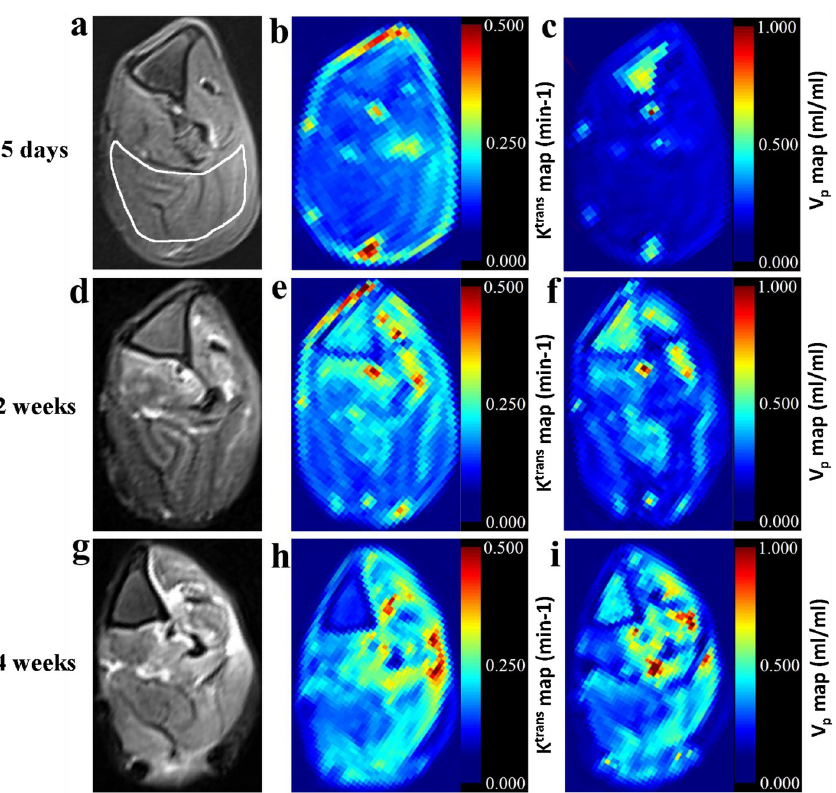
Fig 3. Axial fat-suppressed T2-weighted MR images of the left gastrocnemius muscle (outlined muscle in image) obtained with rabbits in the prone position. (a): At 5 days after surgery, image shows grade 1 signal intensity (ie, signal intensity was isointense or slightly hyperintense compared with that in the control group). (b, c): Color-coded parametric maps are derived from DCE MR imaging. Corresponding K trans and V p values are 4.513 × 10 − 2 min -1 , 0.152ml/ml, respectively. (d): At 2 weeks after surgery, image shows grade 2 signal intensity (ie, intermediate to high signal intensity compared with that in the control group). (e, f): Color-coded parametric maps are derived from DCE-MR imaging. Corresponding K trans and V p values are 11.681 × 10 − 2 min -1 , 0.272ml/ml, respectively. (g): At 4 weeks after surgery, image shows grade 3 signal intensity(ie, high signal intensity compared with that in the control group). (h, i): Color-coded parametric maps are derived from DCE MR imaging. Corresponding K trans and V p values are 16.203 × 10 − 2 min -1 , 0.422ml/ml,